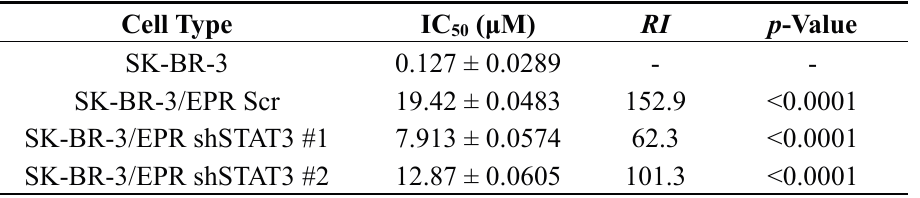
Table 3. IC 50 of epirubicin in SK-BR-3 and SK-BR-3/EPR cells transfected with control or STAT3 specific